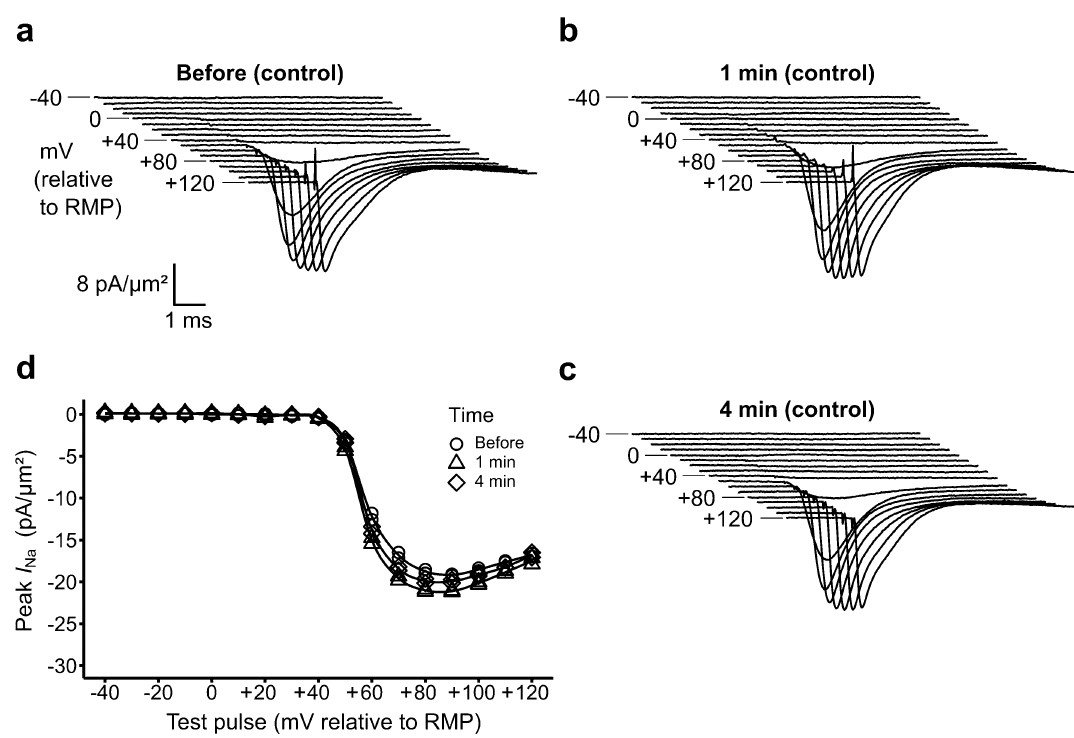
Figure 2. Currents and current–voltage ( I – V ) relationships through control solution changes. ( a – c ) Families of current traces obtained from a patch in response to voltage clamp steps applied relative to resting membrane potential (RMP), ( a ) before, ( b ) 1 min and ( c ) 4 min after solution change to K–H with identical composition to the original bath solution. Each trace shown is the average of two recordings obtained from the set of pulse protocols. It is displaced horizontally and vertically from the previous trace. Currents are shown over the cycle time range of 53–62 ms within the pulse protocol in which the voltage step was delivered at 55 ms. ( d ) Plots of peak current density against test pulse voltage excursion, comparing current–voltage ( I – V ) relationships between the same axes, illustrating a < 12% alteration in maximum peak current following the solution